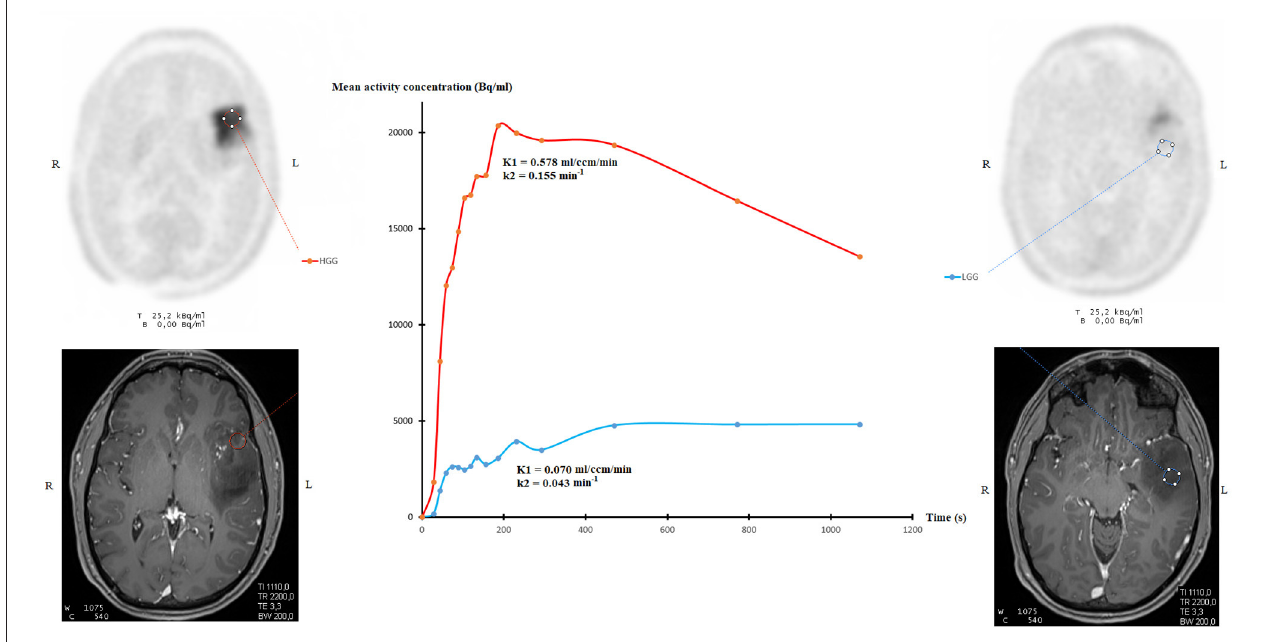
FIGURE 2 | Examples of time-activity curves extracted from a HGG VOI (red line) and extracted from a LGG VOI (blue line) in a 27-year-old man with a left temporal WHO grade III astrocytoma IDH1-mutant, with corresponding CE-MRI image.